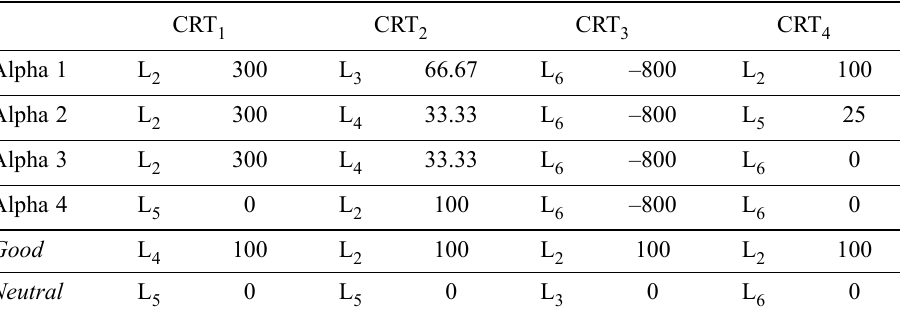
Fig. 8. Partial performance conceptual scheme Table 3. Levels and partial values revealed by the alphas